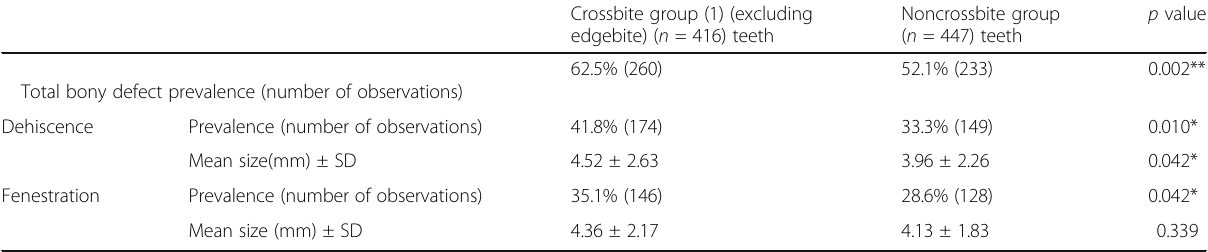
Table 9 Prevalence and mean size of total bony defects, dehiscence, and fenestration in the crossbite group (excluding edgebite teeth) and the noncrossbite group